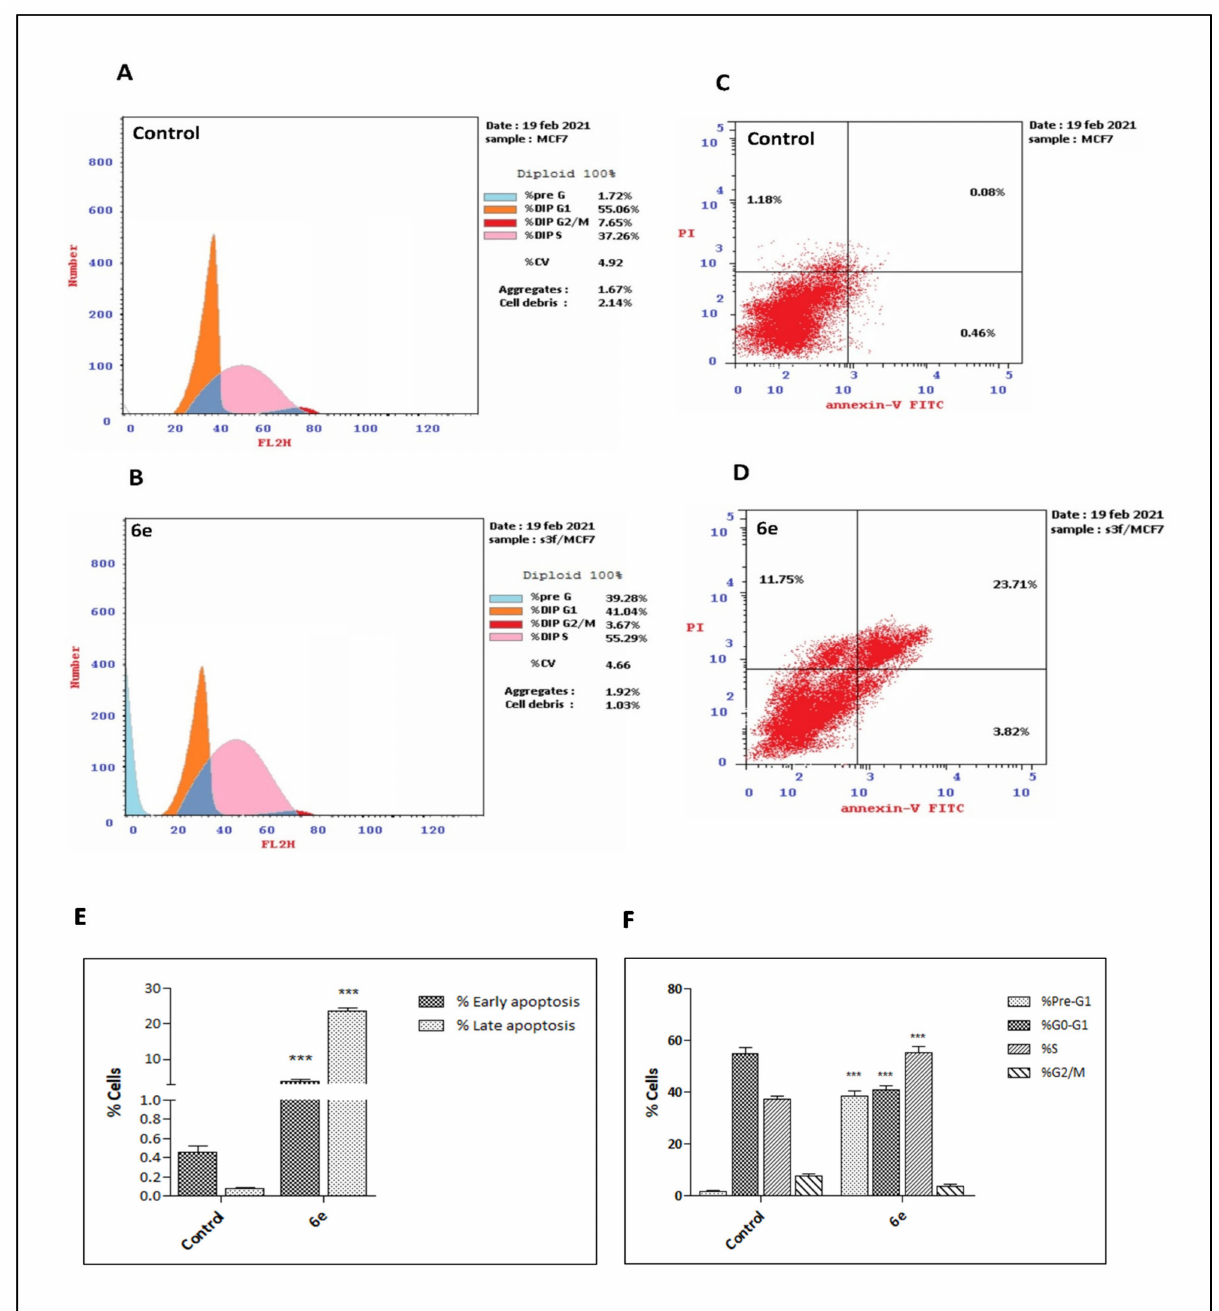
Figure 4. (A and B): DNA-flow cytometry analysis for MCF-7 cells treated with compound 6e for 48h at its IC 50 . 0.1% DMSO was used as a control. (C and D): Induction of apoptosis by compound 6e . Cells were analyzed by annexin V/PI staining after exposure to 6e for 48 h. The percentage of cells enduring apoptosis is described as the sum of early apoptotic (annexin V + /PI − ) and late apoptotic (annexin V + /PI + ) cell percentages. (E and F): Bar charts showing early and late apoptotic cells and comparative analysis of percentage of cells in each cell cycle phase after treatment with compound 6e for 48 h. Values are displayed as mean ± SD of three individual experiments. *** p < 0.001 versus the